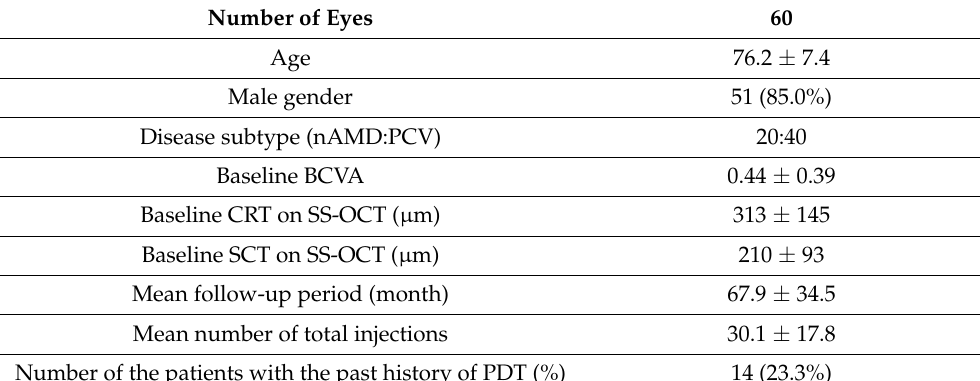
Table 1. Baseline characteristics of the patients with exudative age-related macular degeneration treated with anti-vascular endothelial growth factor agents and switched to brolucizumab. Number of Eyes 60 Age 76.2 ± 7.4 Male gender 51 (85.0%) Disease subtype (nAMD:PCV) 20:40 Baseline BCVA 0.44 ± 0.39 Baseline CRT on SS-OCT ( µ m) 313 ± 145 Baseline SCT on SS-OCT ( µ m) 210 ± 93 Mean follow-up period (month) 67.9 ± 34.5 Mean number of total injections 30.1 ± 17.8 Number of the patients with the past history of PDT (%) 14